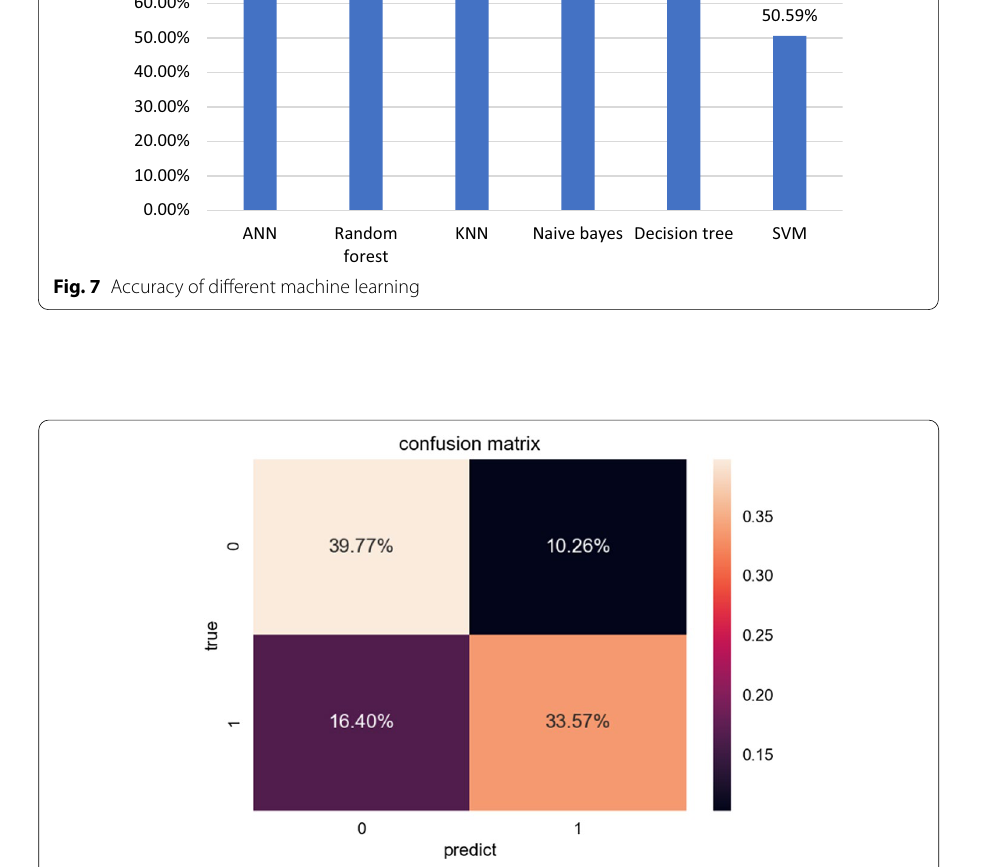
Fig. 8 Confusion matrix for the proposed